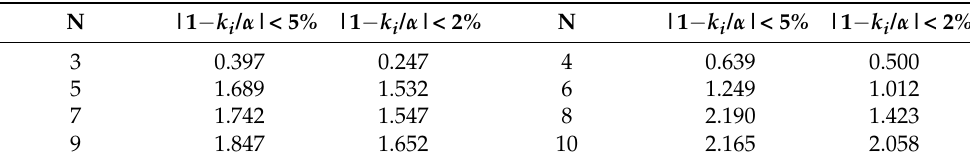
Figure 9. Numerical results by the schemes with N ∈ odd and BM = 1 at t = 2, J = 4.